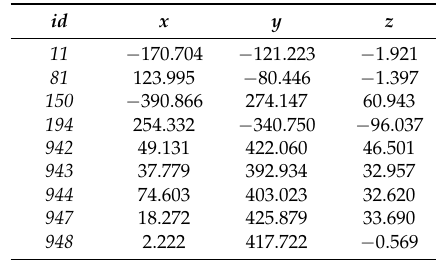
Table 5. Coded (id) target 3D coordinates (mm) after joint bundle of scene at Figure